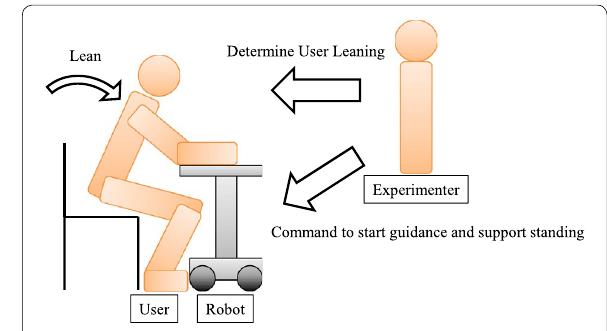
Fig. 4 Overview of the first experiment. The experimenter determines the user’s leaning motion and sends a command to start the stand support function of the